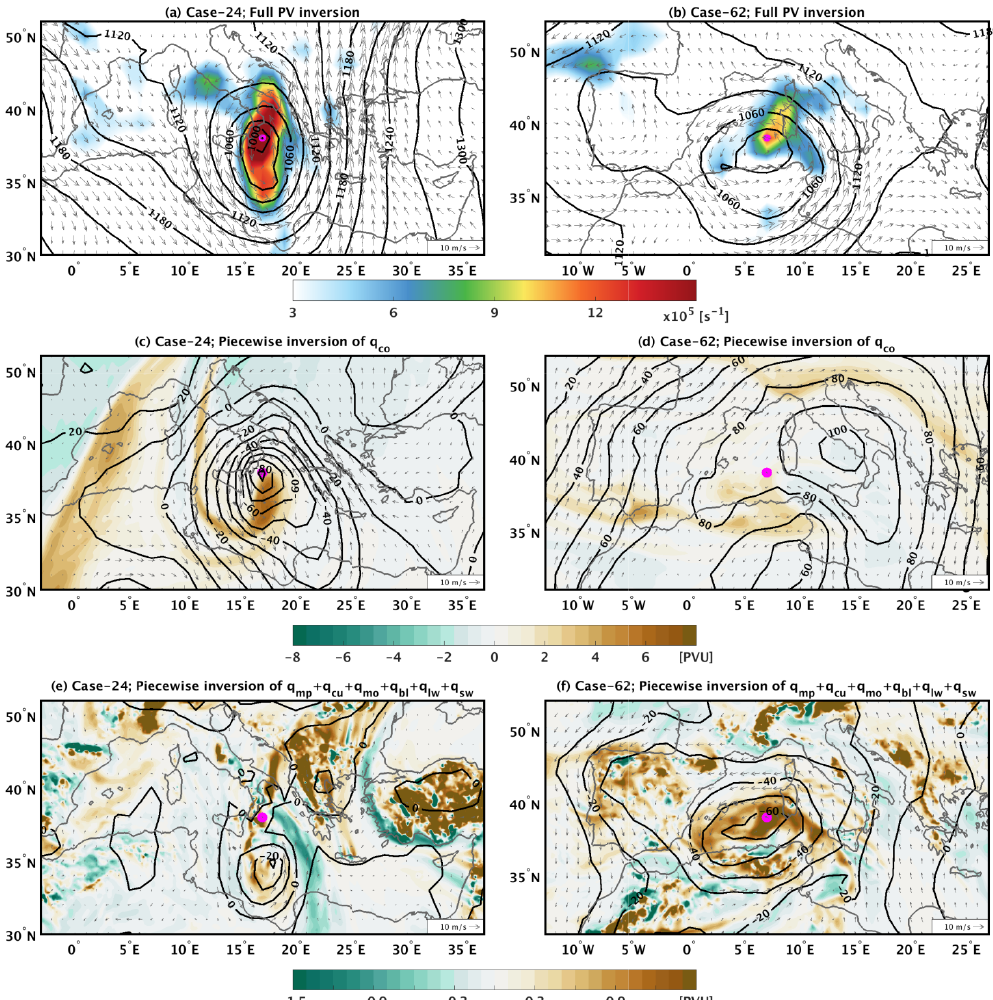
Figure 16. As for Fig. 11 but for case nos. 24 and